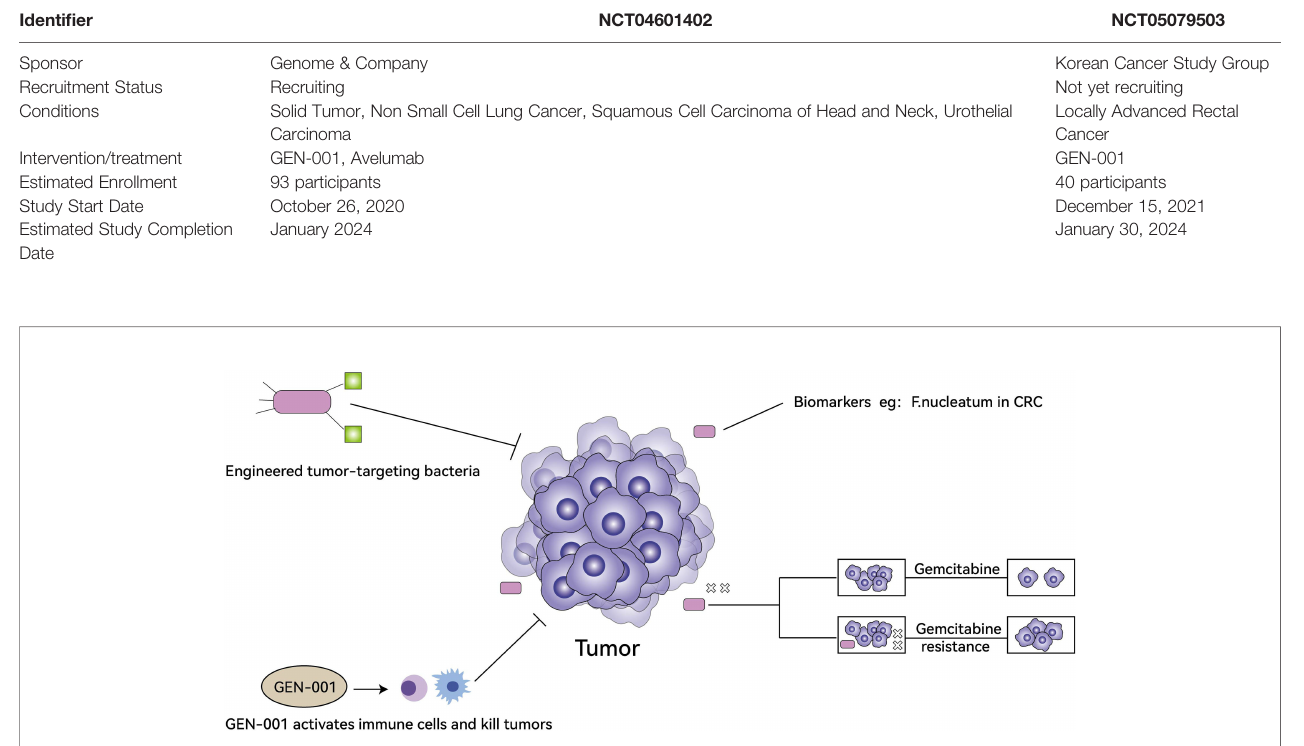
TABLE 2 | Information about the GEN-001 clinical trial (https://clinicaltrials.gov/).